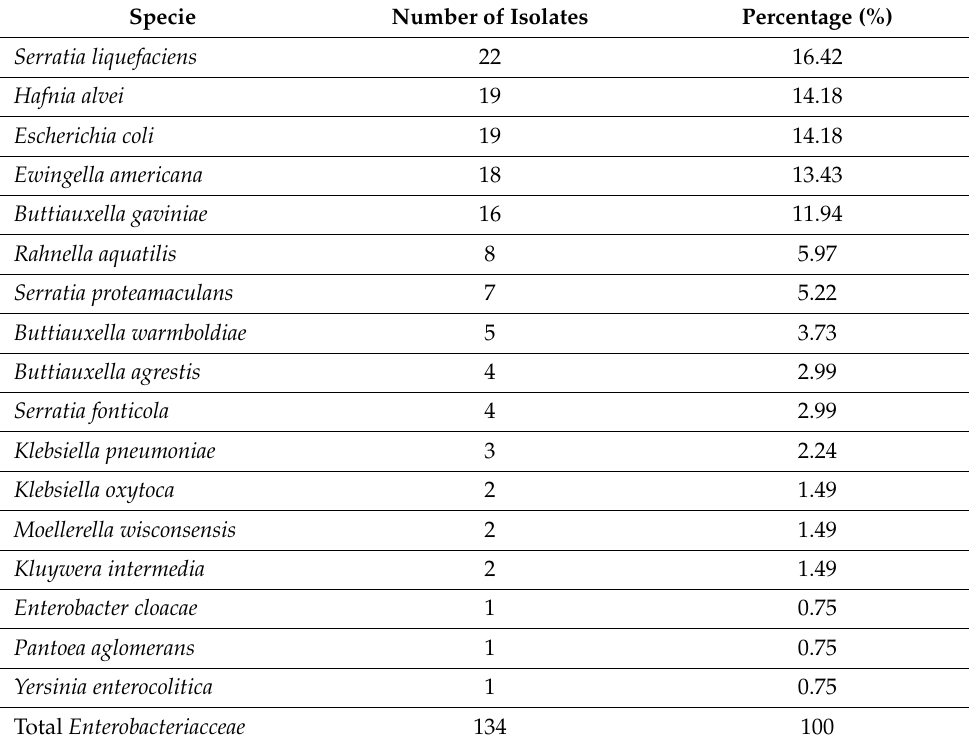
Table 4. Percentage and number of Enterobacteriacceae isolates identified in turkey samples from MacConkey